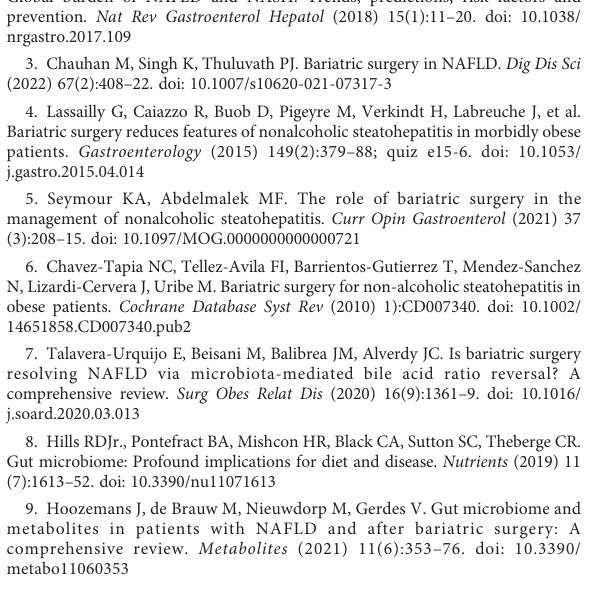
SUPPLEMENTARY FIGURE 1 Quality control of the FMT experiments. (A) Principal component analysis (PCA) of gut microbiota before and after co-housing experiments. PCoA plots show signi fi cant differences in community from different groups in the gut. DIO-SG: The mice which had underwent SG. DIO: The diet induce obese mice. DIO-SG+DIO cohousing: SG mice cohoused with obese mice. n=5 in each group. The mice were female and age matched. (B) PCA of gut microbiota before and after oral gavage of feces experiments. PCoA plots show signi fi cant differences in community from different groups in the gut. (C) Serum GE levels in mice fed with HFD and HFD+GE.